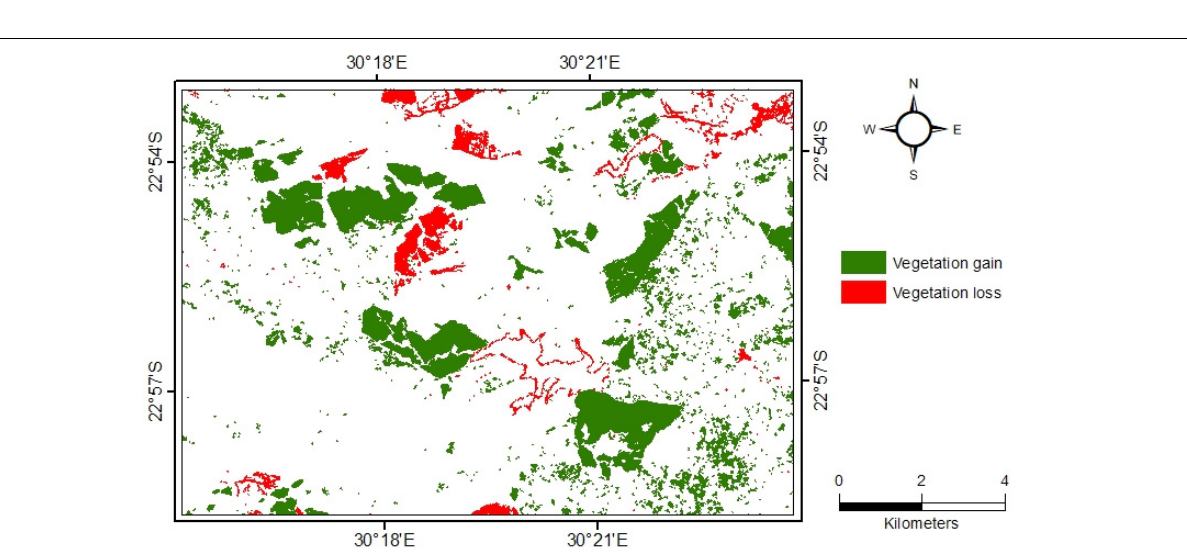
Figure 5: The ISODATA classification of the difference image.